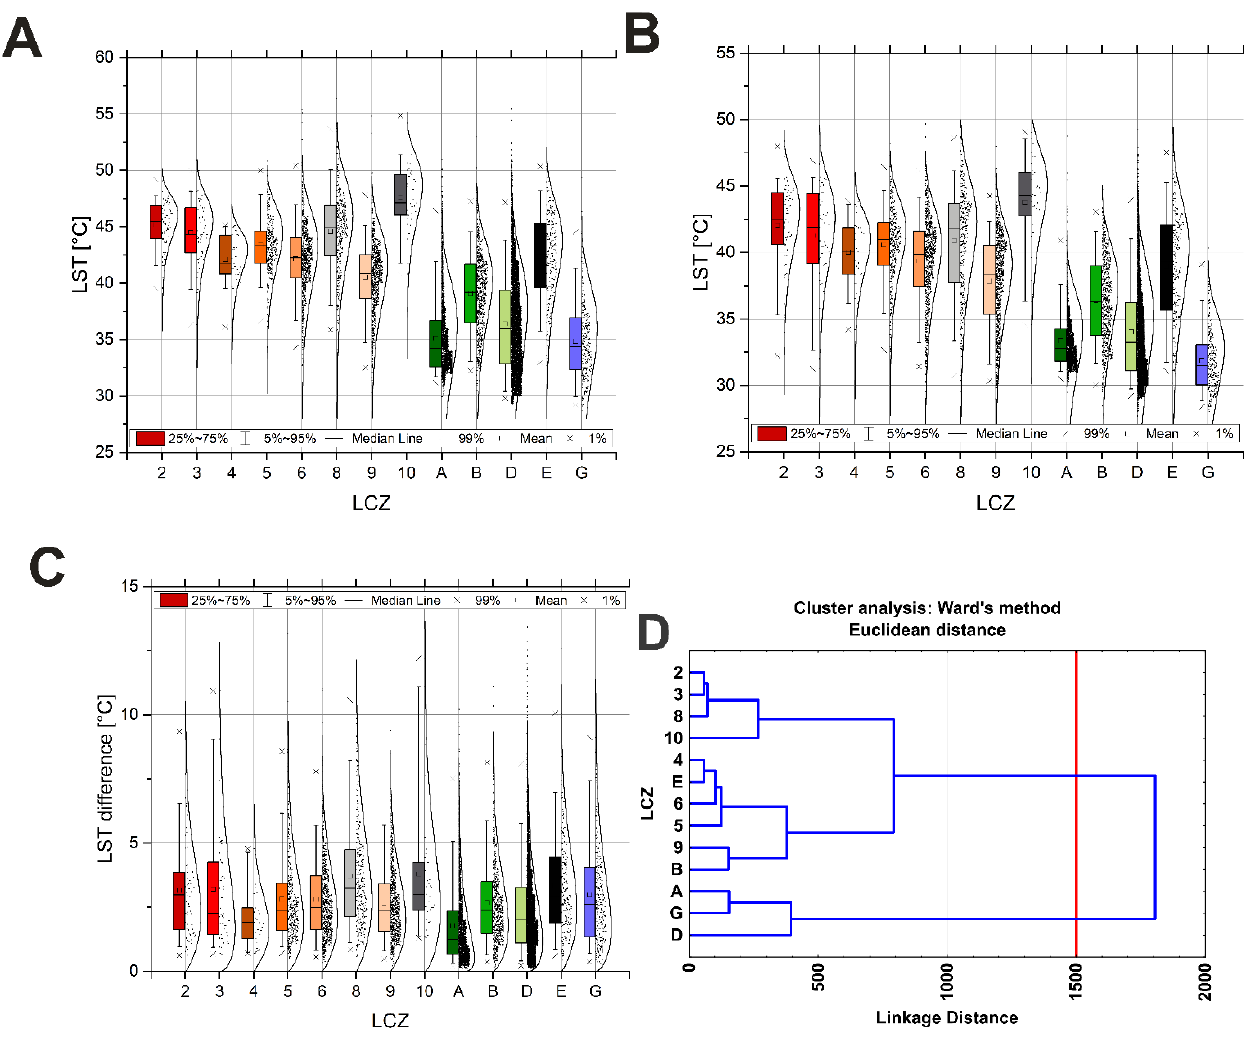
Figure 6. Box-plots with LSTs in LCZ classes in 18 June 2013; see Figure 3 for the LCZ key. Left up ( A ) mean maximum of LST; right up ( B ) mean minimum of LST; left down ( C ) mean difference (mean max LST minus mean min LST), values that are below/above the cross in the graph can be considered outliers when the cross symbolizes 1% of the values; right down ( D ) results of cluster analysis—the vertical red line represents the linkage chosen to select the clusters (red line in the cluster analysis refers to α = 0.05 significance level).